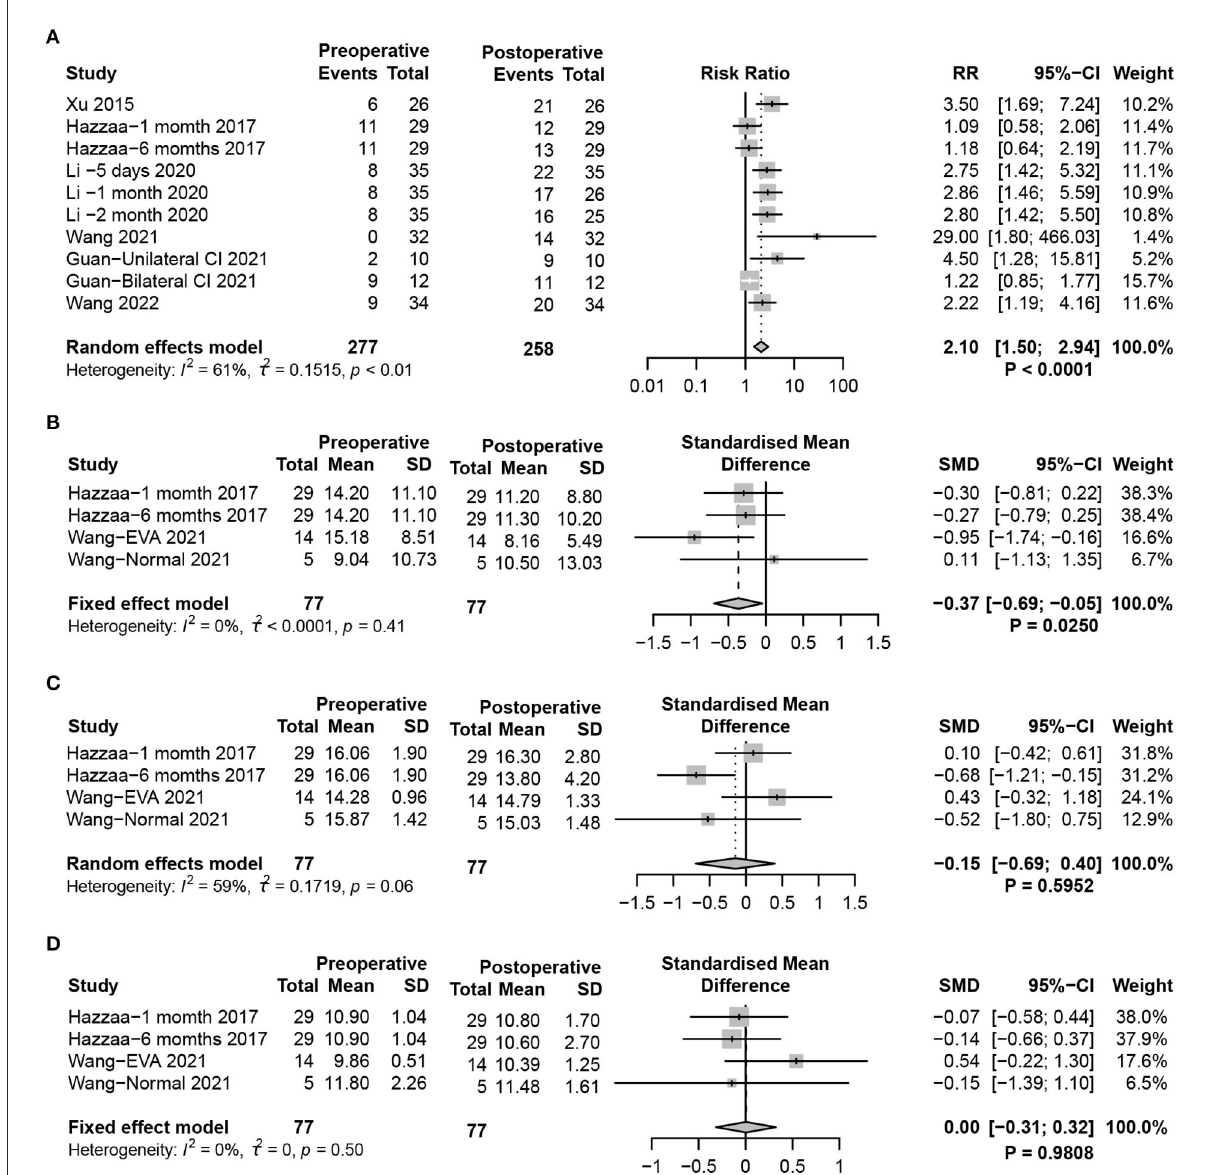
FIGURE3 Forest plots showing utricle function test results between pre- and post-surgery groups. (A) Response to the oVEMP test. (B–D) Response of oVEMP parameters including (B) P1-N1 amplitude, (C) P1 latency, and (D) N1 latency. Study, included studies for Research on meta-analysis; Preoperative, results of vestibular function test before operation; Postoperative, results of vestibular function test after operation; Events, number of people with abnormal vestibular function test results; Total, total number of patients in the study; Mean, arithmetic mean; SD, standard deviation; RR, relative risk; 95%-CI, 95% confidence interval; SMD, standardized mean difference; Weight, weight of each study in statistics.